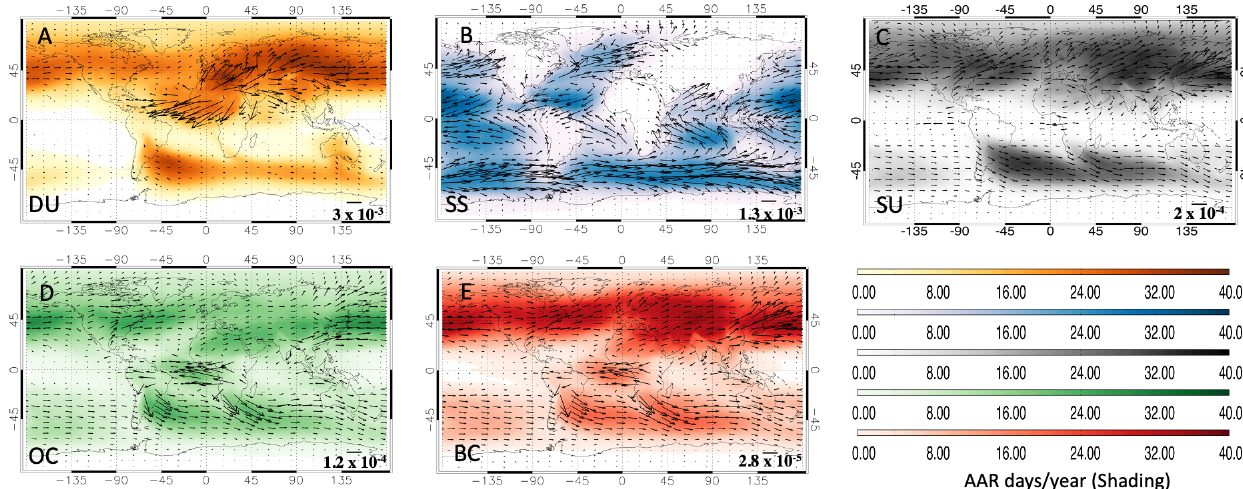
Figure 4. Annual climatological AAR frequency (days per year; shading) and IAT (arrows; kgm − 1 s − 1 ) during 1997–2014 based on MERRA-2. (a) Dust. (b) Sea salt. (c) Sulfate. (d) Organic carbon. (e) Black carbon. Scales for the IAT vectors are provided in the lower right side of each